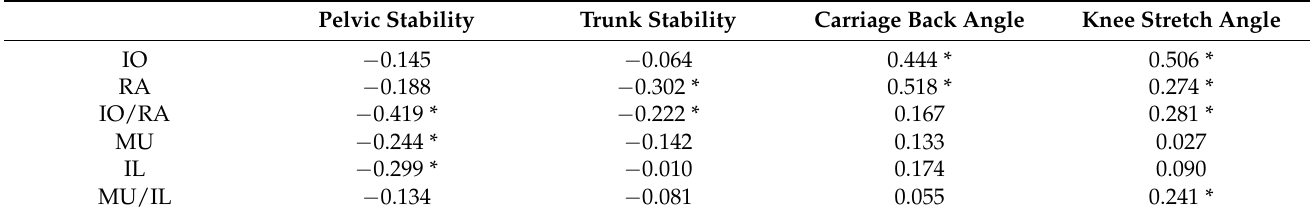
Table 4. Correlation between muscle activation and kinematic